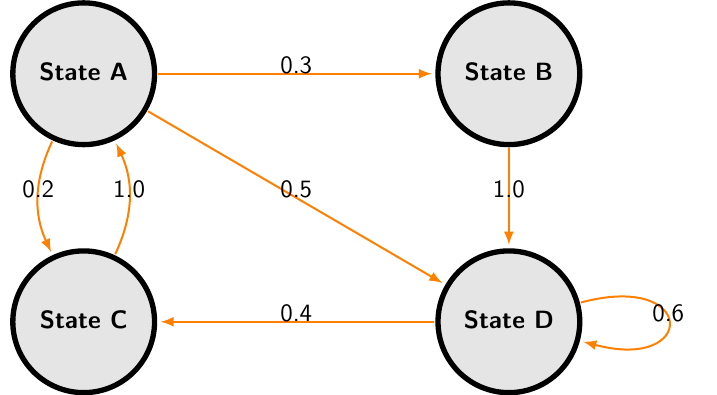
Figure 3. Markov chain. The arcs connecting the nodes/states indicate the transition probability between